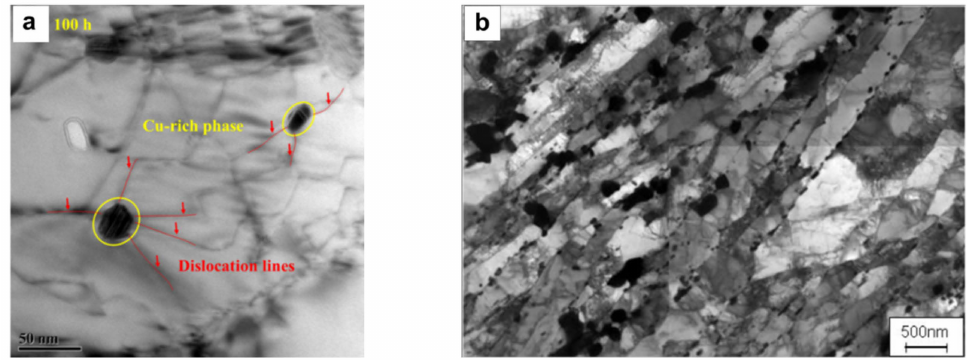
Figure 13. ( a ) TEM image showing the interaction between dislocations and precipitates of Cu-rich phase in the G115 steel after 100 h of creep at 650 ◦ C, 140 MPa. Reprinted with permission from Ref. [33]. Copyright 2019, Elsevier. ( b ) Lath structure in the SAVE12AD steel after creep at 650 ◦ C, 108 MPa, for 20,687 h. Reprinted with permission from Ref. [34]. Copyright 2017 ASME.